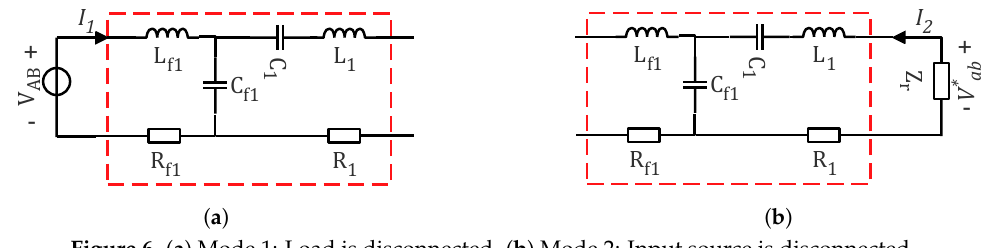
Figure 6. ( a ) Mode 1: Load is disconnected. ( b ) Mode 2: Input source is